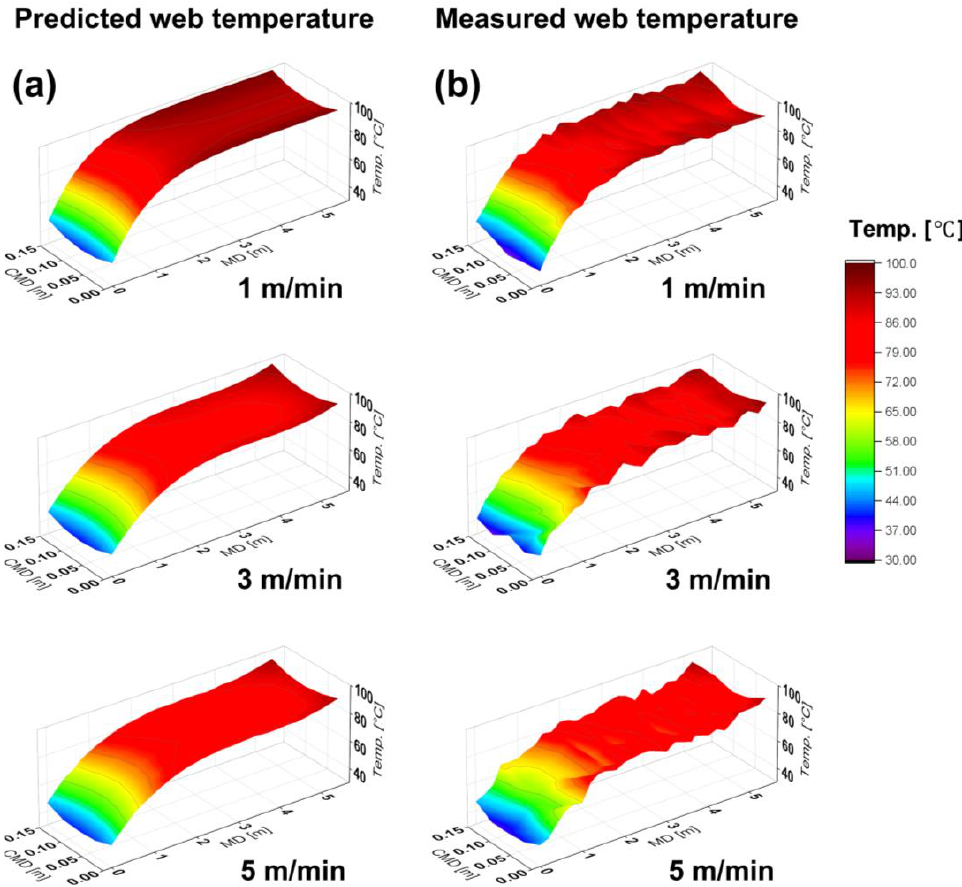
Figure 6. Web temperature in dryer depending on operating speed: ( a ) predicted web temperature with computational fluid dynamics analysis; ( b ) measured web temperature through roll-to-roll web transporting experiment.